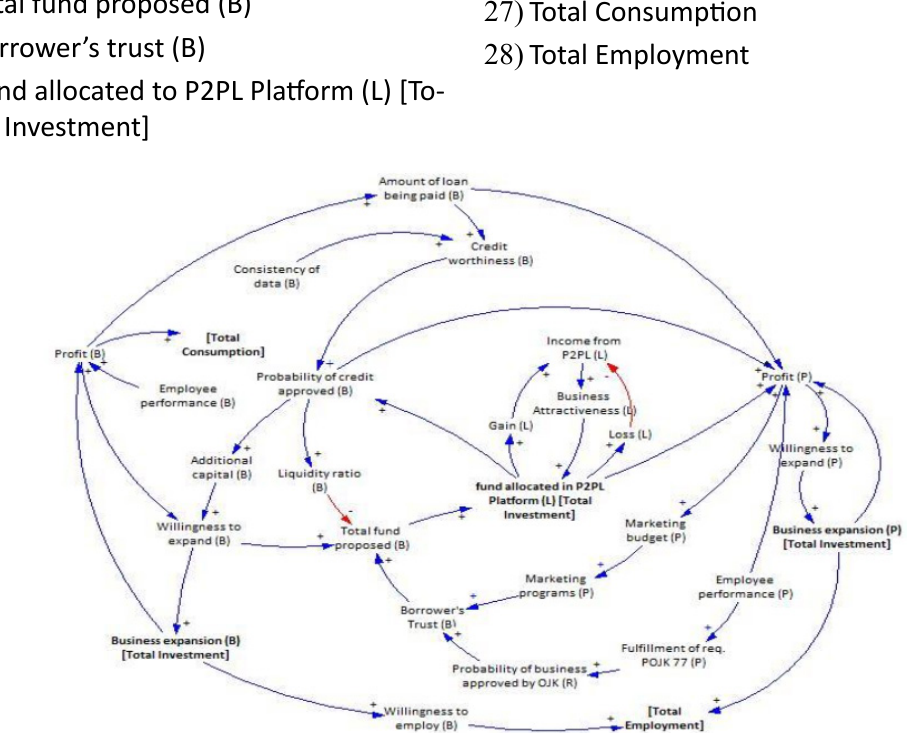
Figure 1: Causal Loop System